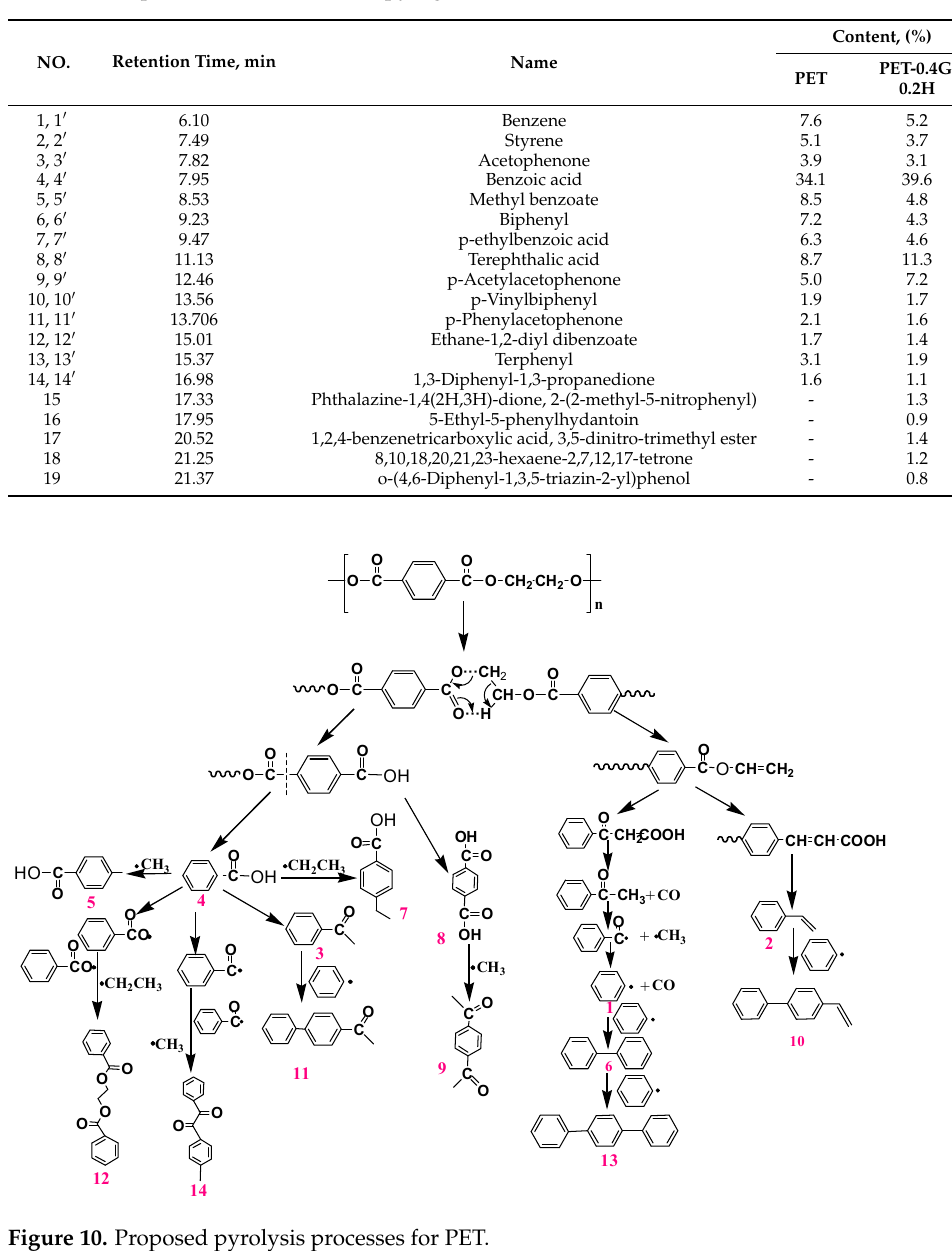
Table 6. Compounds identified in the pyrograms of PET and PET-0.4G-0.2H.